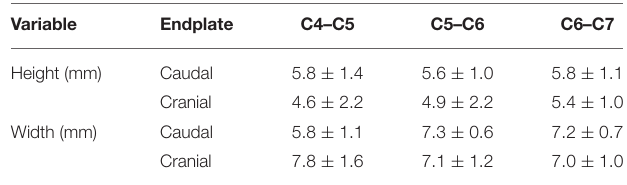
TABLE 2 | Dimensions (mean ± SD) of the cranial and caudal cervical vertebral endplates in